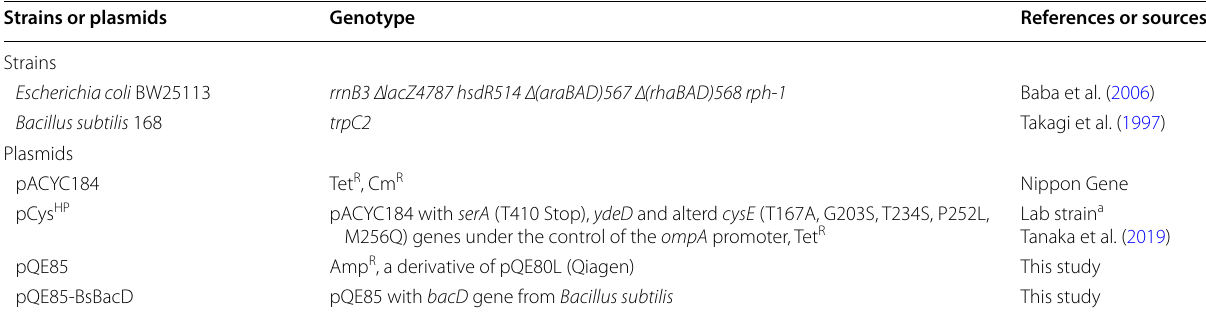
a The plasmid pDES (with serA [T410 Stop], ydeD and altered cysE [T167A] genes) from ajinomoto is first supplied (Wiriyathanawudhiwong et al. 2009). However, this plasmid was accidentally obtained in our laboratory during 10 years of stock